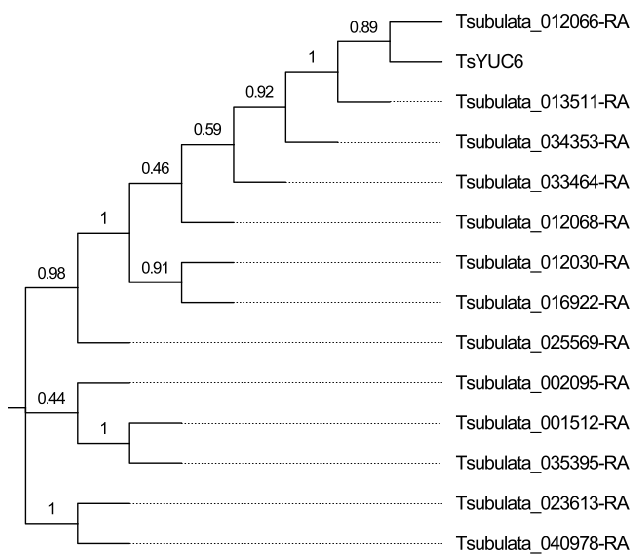
Figure 7. Phylogenetic relationship of the YUCCA gene family in Turnera subulata . Generated using MEGA11 [30]. Values at nodes represent proportions from 1000 bootstrap replicates. Additional information related to motifs and intron/exon structure can be found in Supplementary Figure S11.